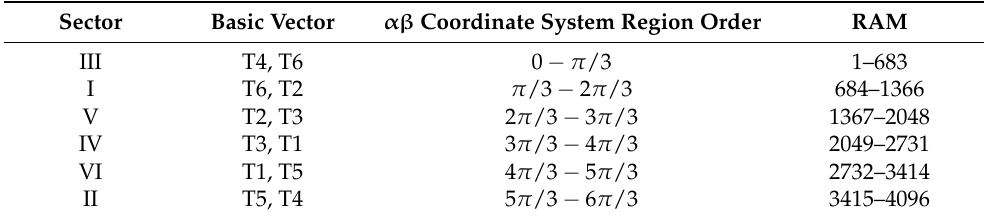
Table 6. Corresponding relationship of sector, basic vector, αβ coordinate system region order, and RAM.